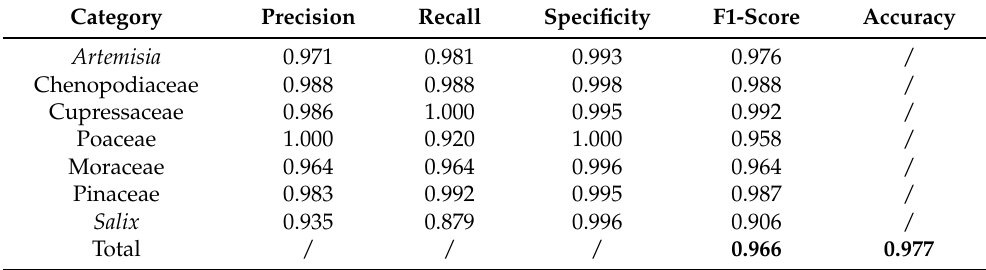
Table 6. The classification results for the multi-scale classifier with the Resnet-50